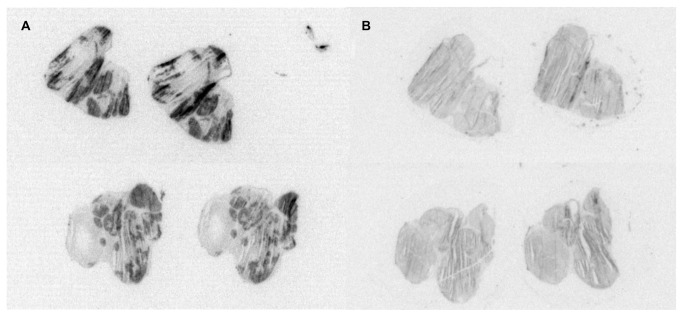
Heterogeneous ex vivo peptide uptake versus homogeneous receptor expression.Illustration of the heterogeneous SPECT peptide uptake in ex vivo autoradiography (A), with the corresponding homogeneous receptor expression in in vitro autoradiography (B), for a pancreatic neuroendocrine tumor model (CA20948).